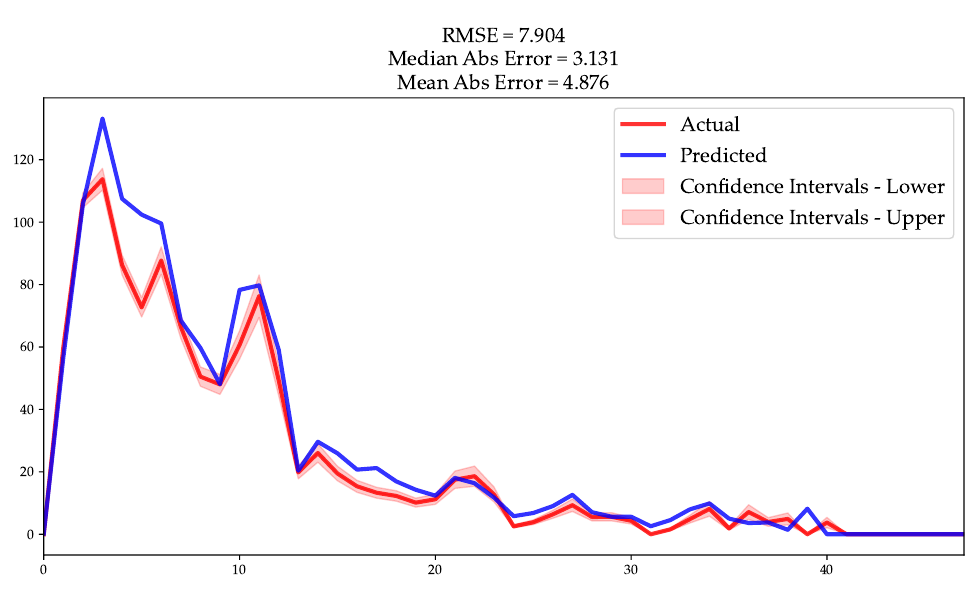
Figure 5. Global model performance predicted versus